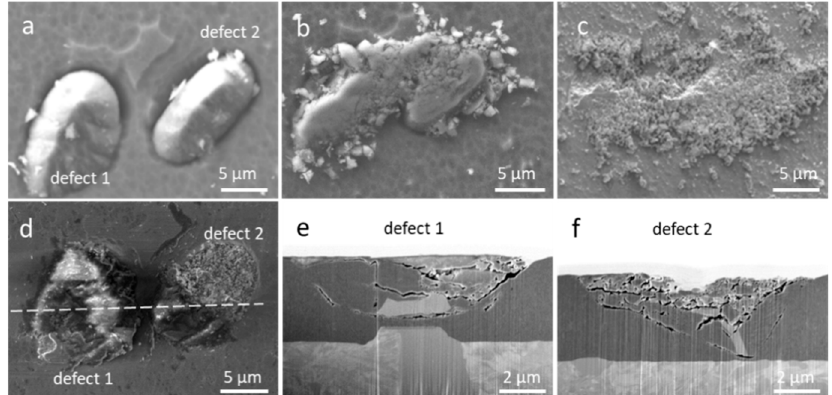
Figure 28. SEM images of the same nodular defects in the sputter-deposited TiAlN hard coating: as-deposited ( a ) and in the wear track after 1 cycle ( b ), 4 cycles ( c ), and 128 cycles ( d ) using an alumina ball (2 N, 2 Hz). FIB cross-section images (in direction marked with the dashed line) of both defects after 128 cycles ( e , f ).